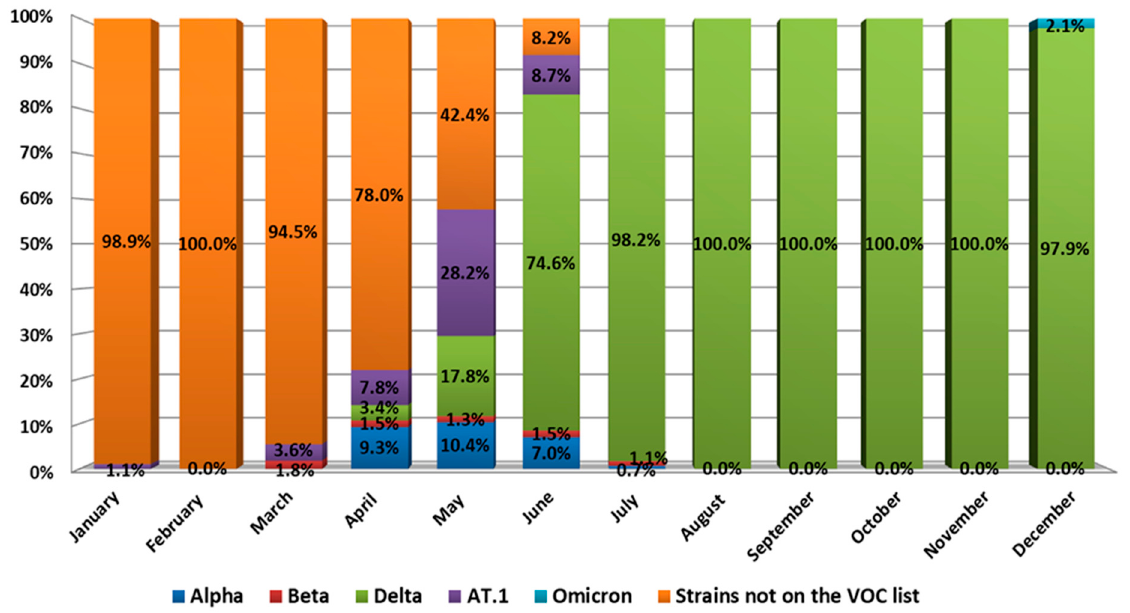
Figure 6. SARS-CoV-2 genetic diversity in northwest Russia. From January to May 2021, various SARS-CoV-2 genetic variants, including VOCs, circulated in northwest Russia. However, from the beginning of June, they were completely displaced by the Delta variant.